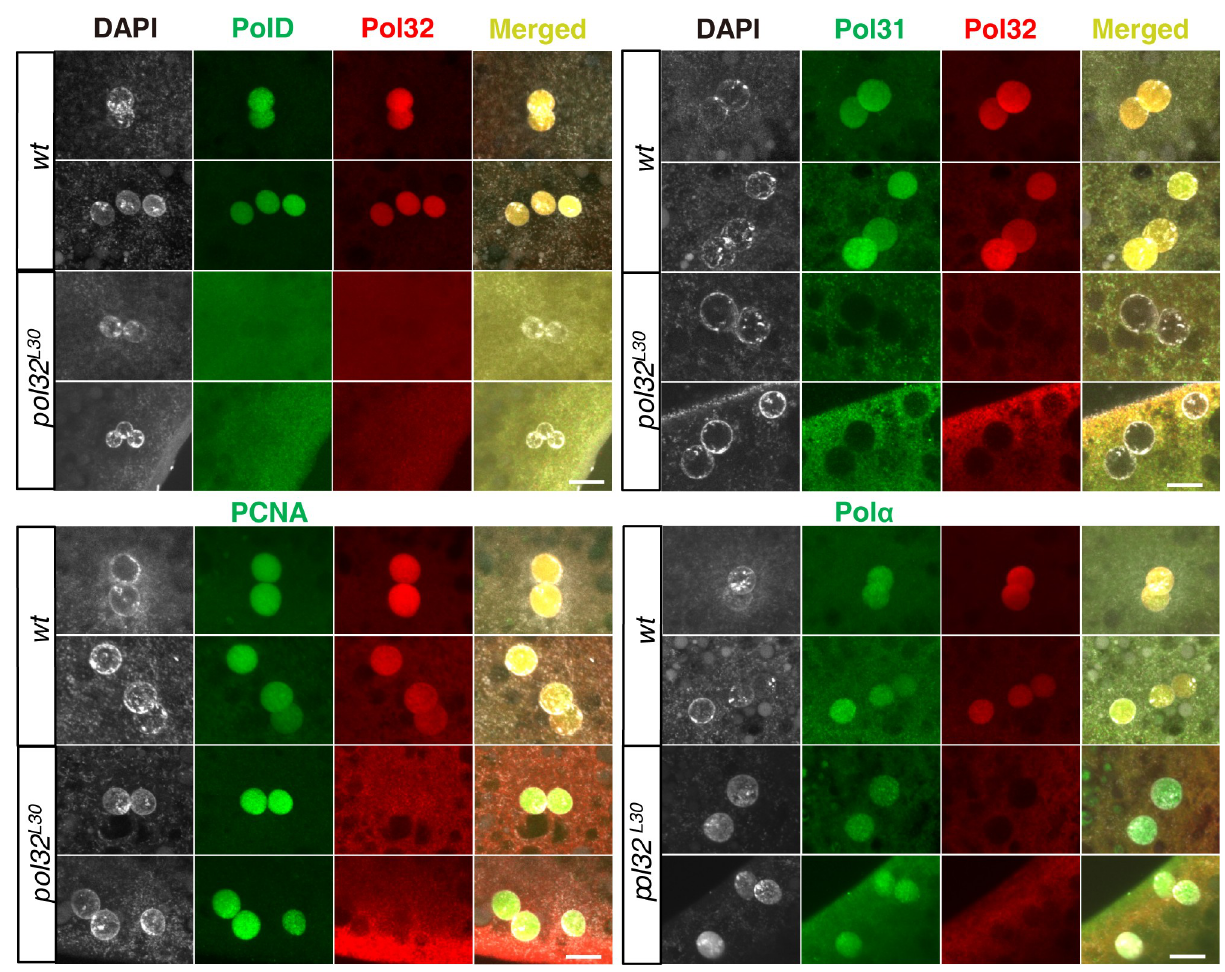
Fig 3. Pol δ complex is absent in embryonic nuclei of pol32 mutants. Representative confocal images of antibody staining of the Pol δ complex (PolD, Pol31 and Pol32), PCNA and Pol α in wild-type and pol32 -mutant 0-2hr old embryos. For each antibody, 50 wild-type embryos were imaged. The number of pol32 -mutant embryos imaged for each antibody are: 70 for PolD, 71 for Pol31, 52 for PCNA, and 59 for Pol α . Scale bars indicate 10 μ m.